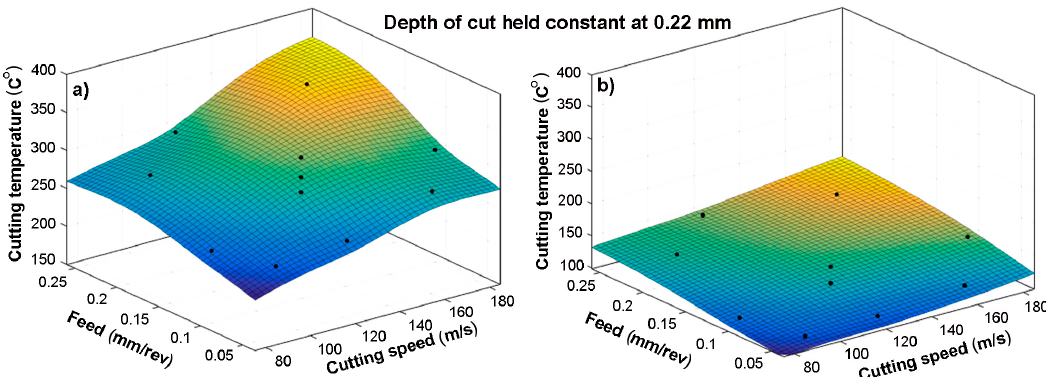
Figure 6. The surface 3D viewer for the cutting temperature of both tool materials: ( a ) HM and ( b ) CBN.